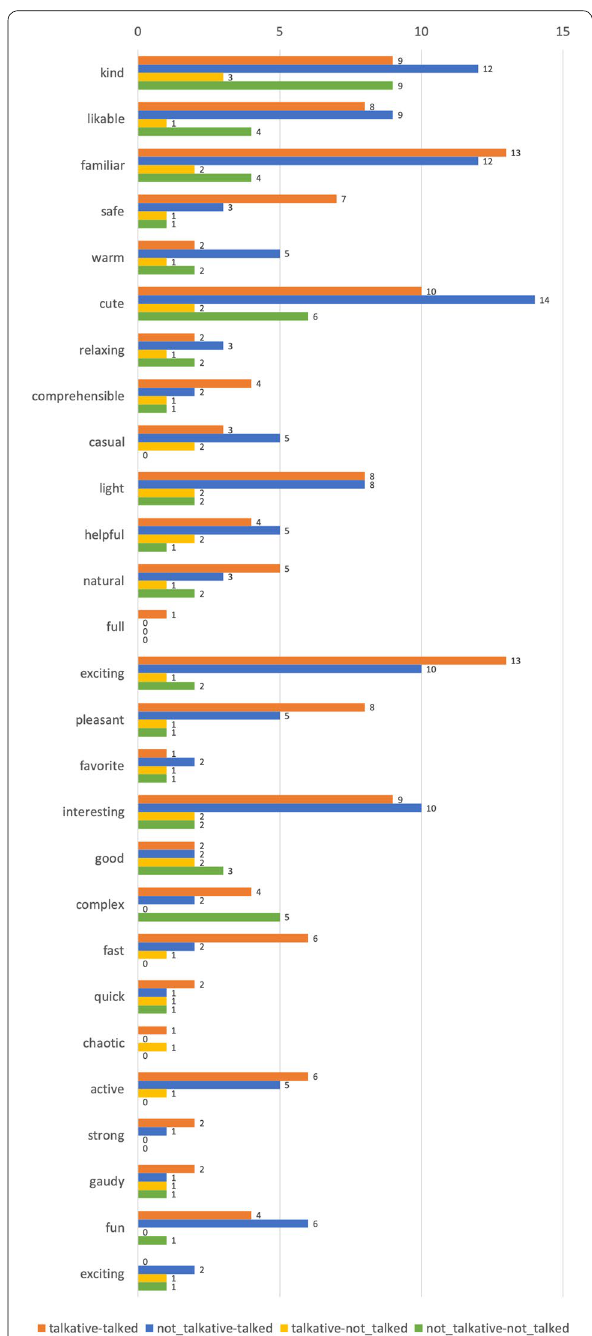
Fig. 4 Number of impressions selected from 27 positive expressions of adjectives, N = 73 (talkative-talked: 26, talkative-talked: 23, talkative-not talked: 8, not talkative-not talked: